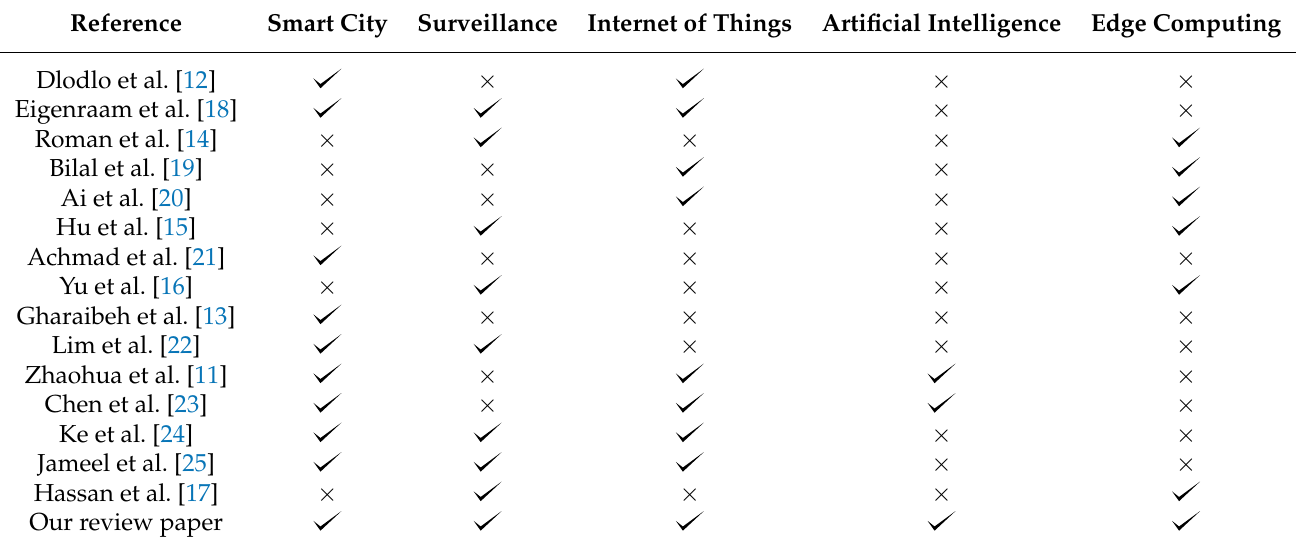
Table 1. Summary of existing review